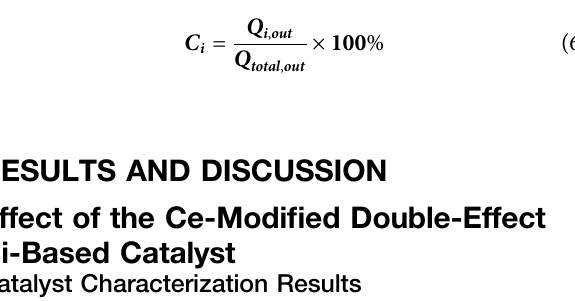
Frontiers in Energy Research |